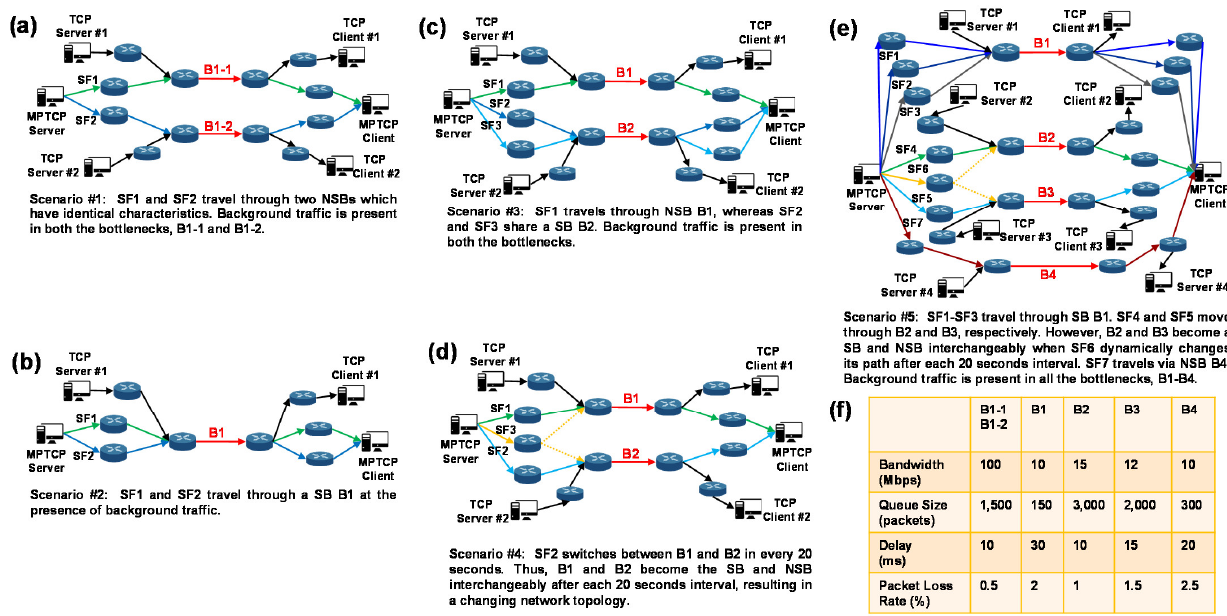
Figure 6. Schematic of the considered scenarios for the performance evaluation. ( a – e ) Scenarios #1–5, ( f ) properties of different bottleneck links contemplated in the considered scenarios.